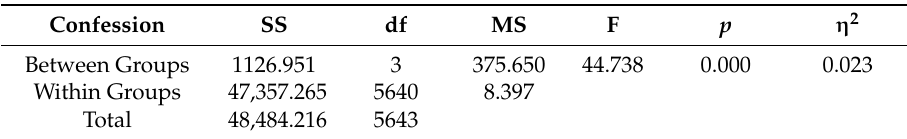
Table A2. Level of religiosity among confessions.